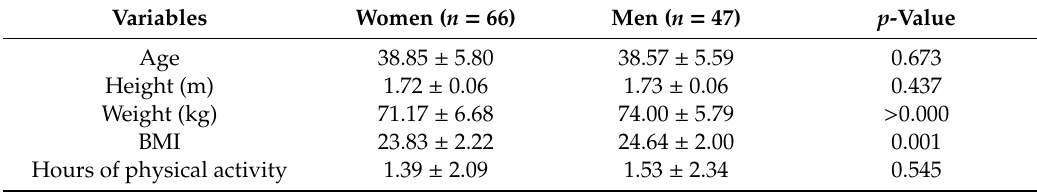
Table 1. Mean ± SD according to sex; age; height (m); weight (kg); BMI; PA hours; PA status.